Question: Write a single sentence explaining what this figure depicts.
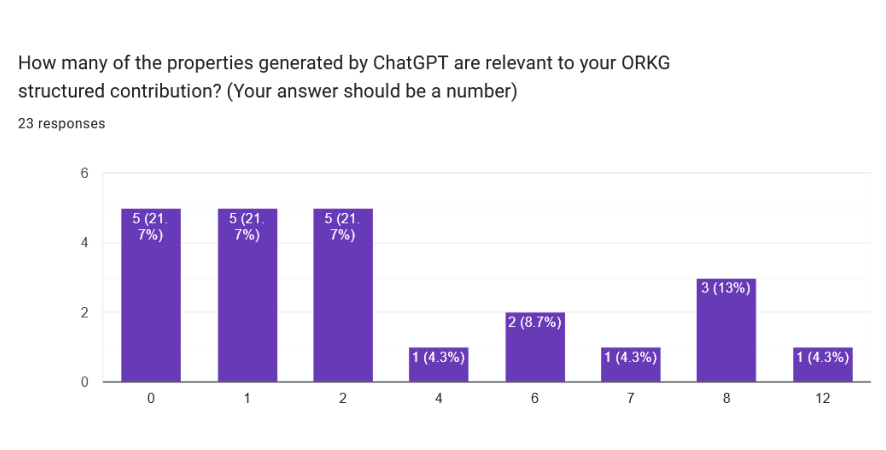
Answer: Count of the number of relevant LLM-generated research dimensions to struc- ture a paper’s contribution or create a structured science summary.